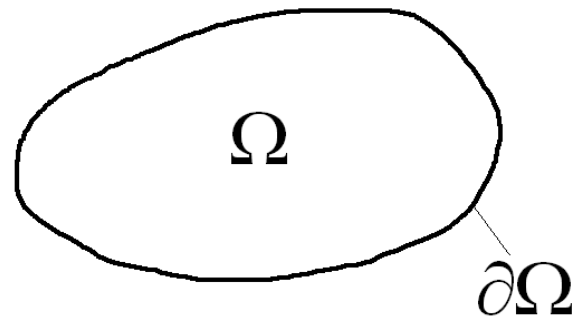
∂Ω Ω and its boundary .